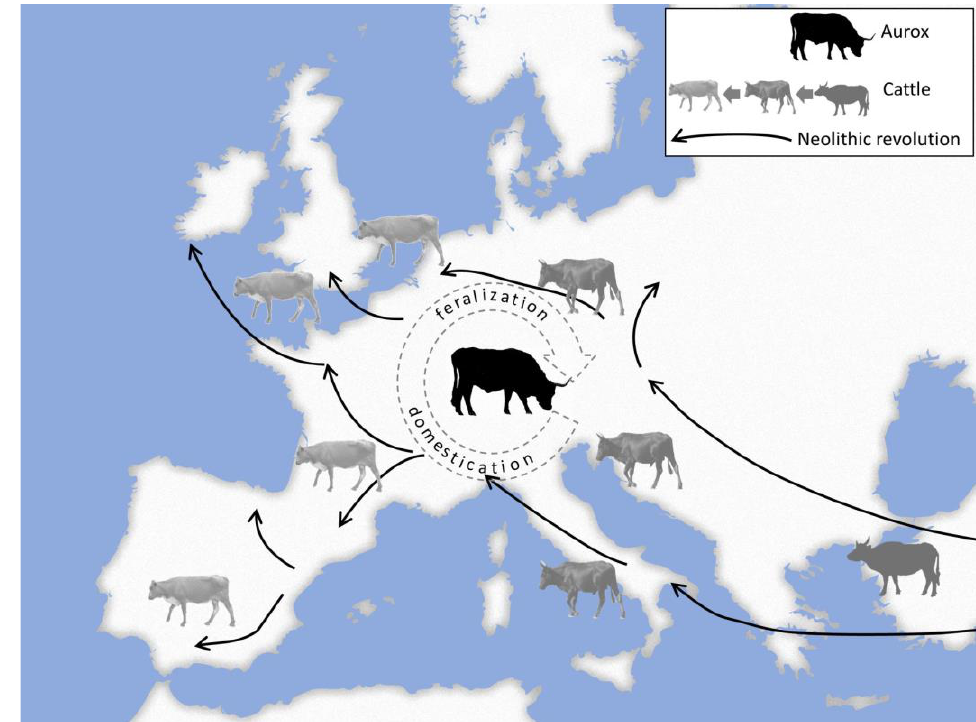
Figure 2. Ongoing interrelations between domestication and feralization as the Neolithic Revolution progressed into central Europe. Both processes were entangled as the wild taxon was around and the domestic taxon was not really detached from the natural environment. Domestic animals feralize and the hybrids of feralized domestic and wild animals may be re-incorporated into the human sphere as animal herders might consider this desirable. Photos: T. Göttert .